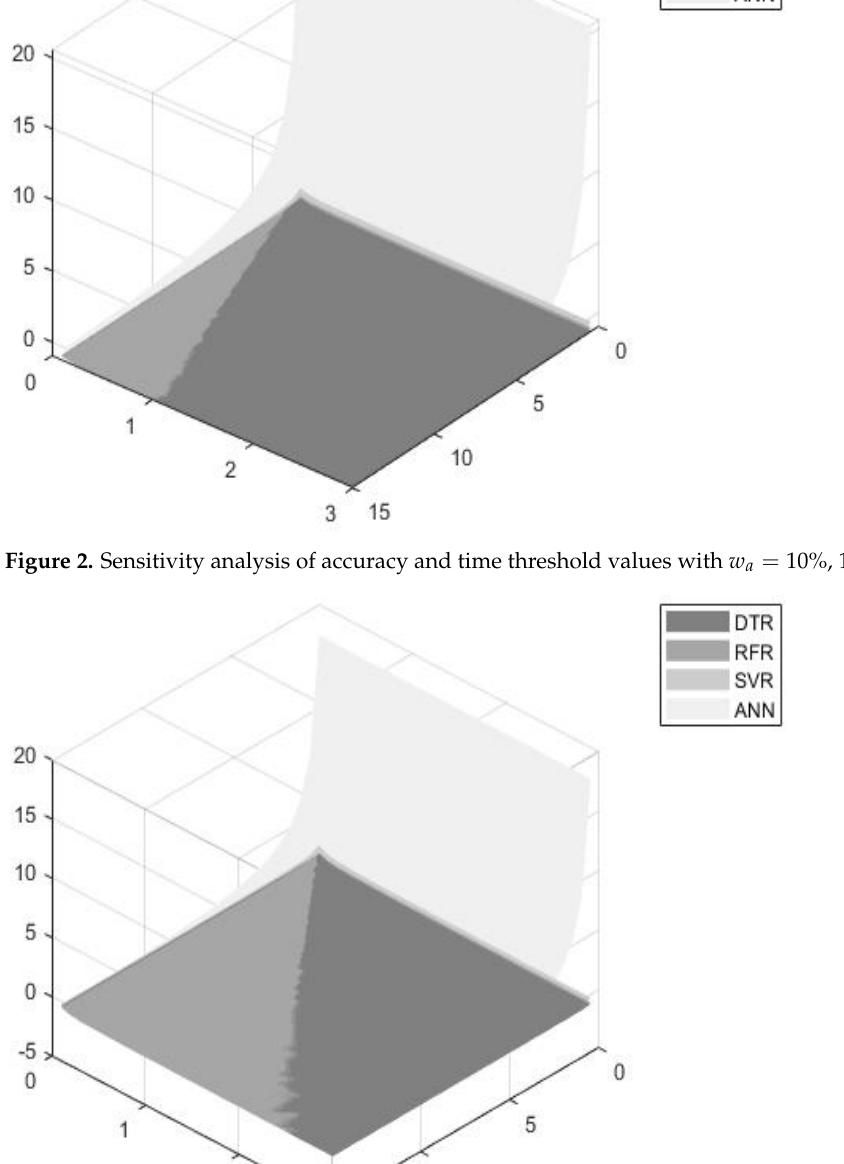
Figure 3. Sensitivity analysis of accuracy and time threshold values with w a = 20%, 1 − w a = 80%